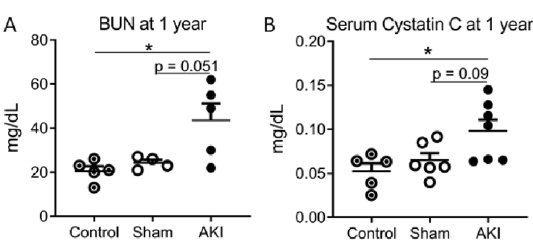
Figure 2. Serum biomarkers of kidney function in females 1 year after AKI or sham, compared to healthy age-matched controls. 12 months after AKI, blood urea nitrogen ( A ) and serum Cystatin C ( B ) were elevated compared to controls, and approached significance compared to shams. (n = 5–7) *Signifies P <